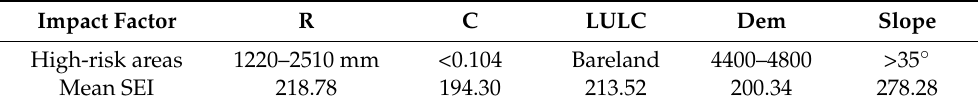
Table 11. Risk detection value of each factor of SEI in